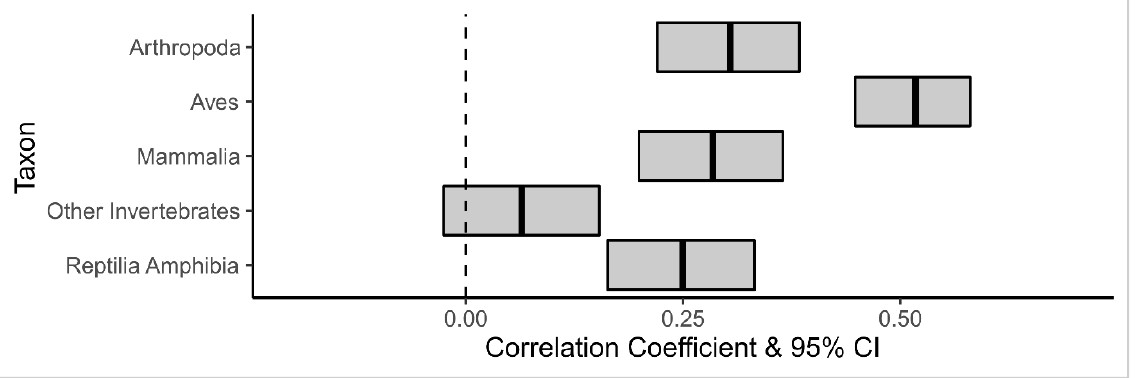
Figure A4. Correlations between attitudes towards and familiarity with each taxon. If the correlation coefficient is left of the dashed line at 0, that indicates a negative correlation; if the correlation coefficient is right of the dashed line at 0, that indicates a positive correlation. The boxes represent the estimated correlation coefficient ± 95% CI. N = 475.